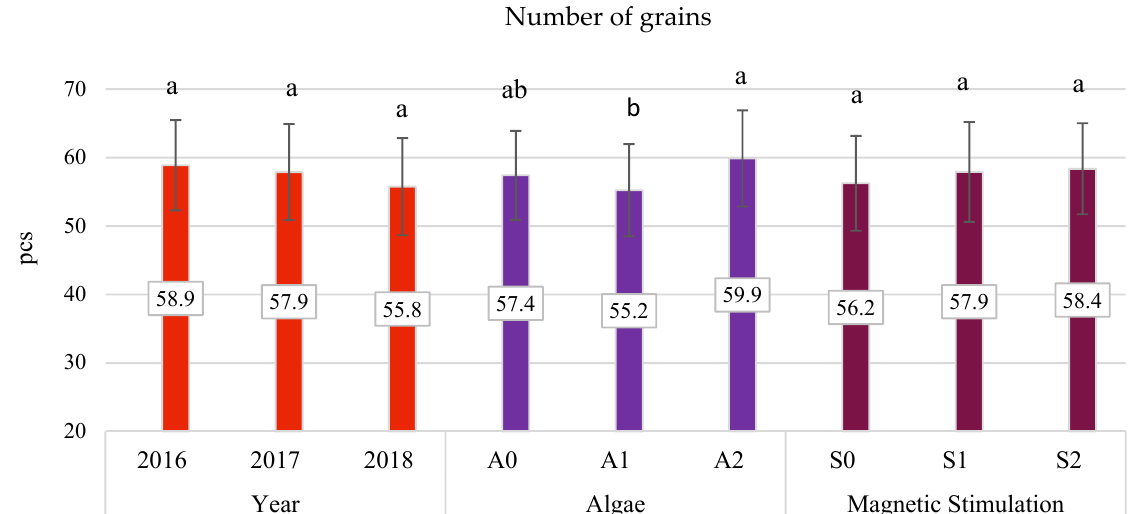
Figure 13. Effect of the alga dose and the MF exposure per number of grains from oat panicle (pieces) from 2016 to 2018. According to Tukey’s HSD (honest significant difference) test, the means marked with the same letter were not significantly different at α ≤ 0.05.